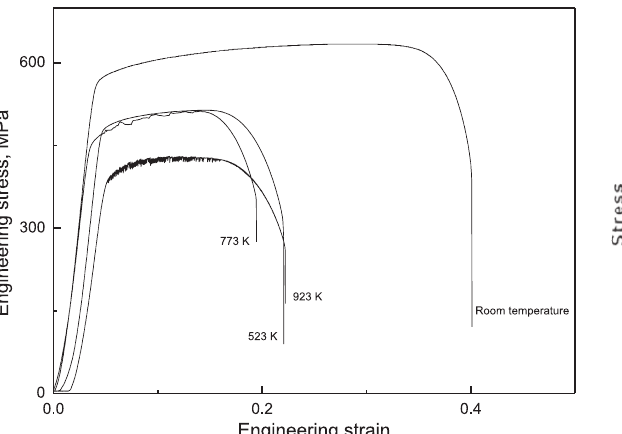
Fig. 3: A schematic showing the smoothening and averaging procedure used for serrated stress strain curves.